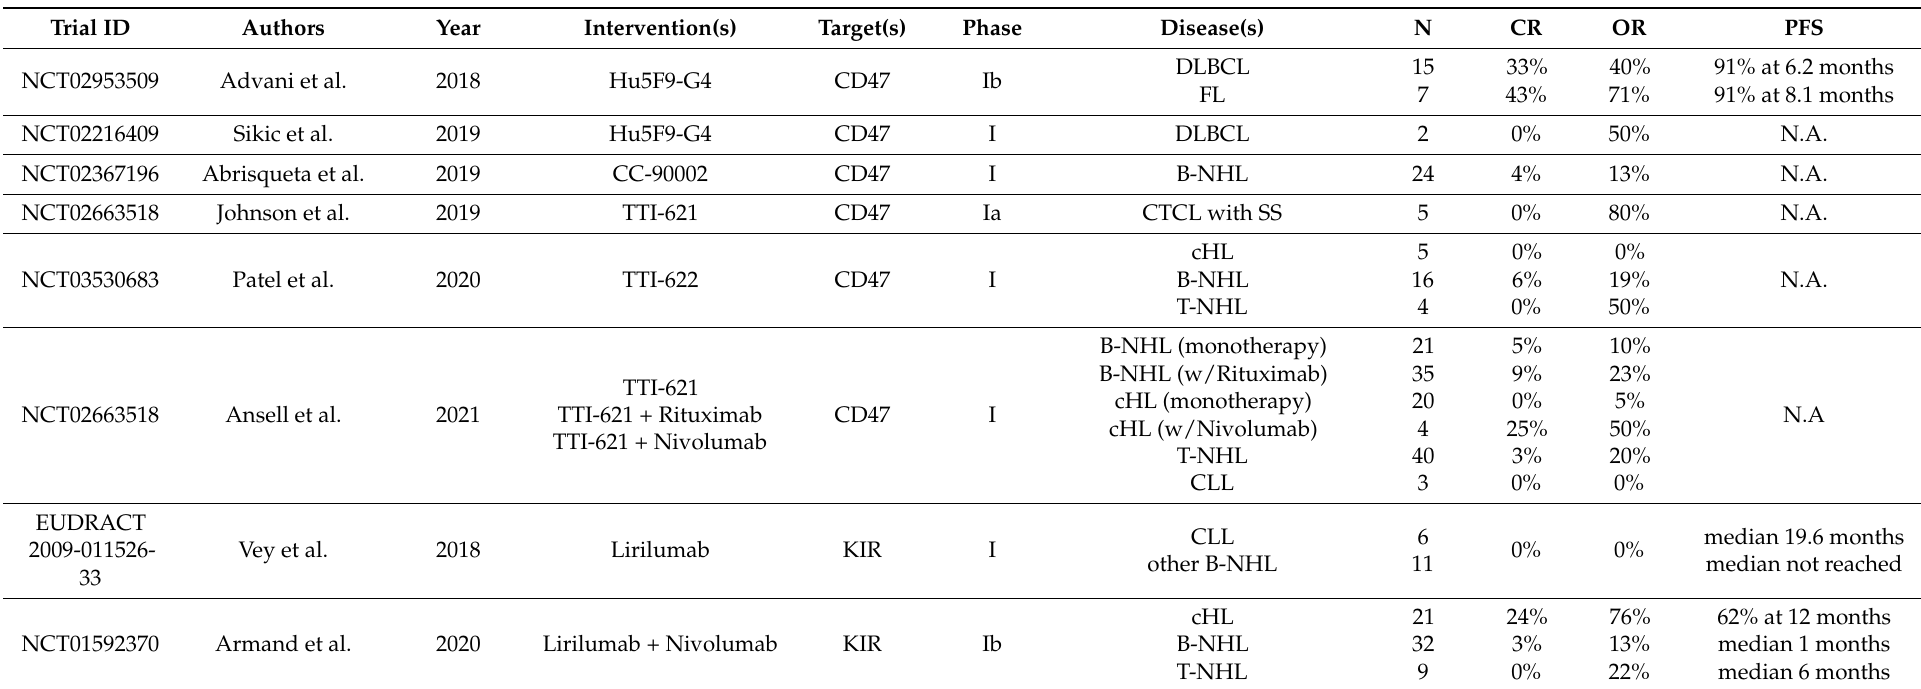
Table 6. Clinical trials of innate checkpoint inhibitors in